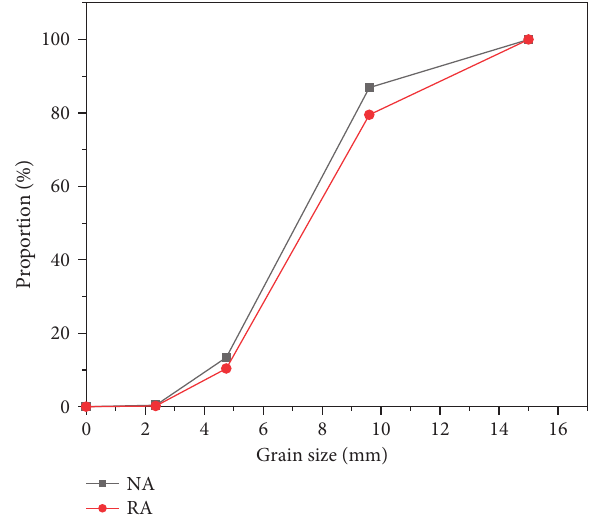
Figure 1: The gradation of coarse aggregates. Table 1: Properties of aggregate.